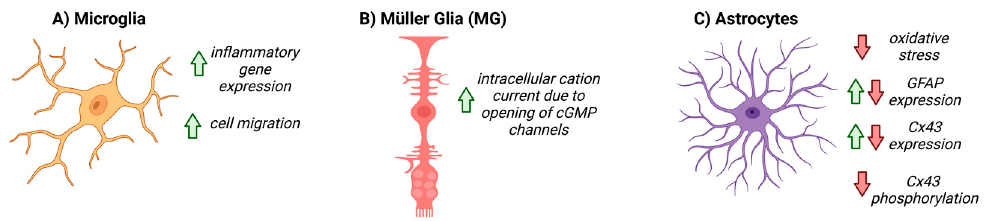
Figure 3. The known effects of cGMP on glial cells. Red arrows represent downregulation, or negative activity, green arrows represent increased expression, or positive activity. ( A ) cGMP upregulates inflammatory gene expression and cell migration in microglia, ( B ) increases cation current within Müller cells via opening of cGMP-gated channels, and ( C ) decreases oxidative stress, differentially affects GFAP and Cx43 expression, and decreases Cx43 phosphorylation in astrocytes. In cell types outside of the CNS, Cx43 expression and function is mediated by cGMP (SNAP) or 8-Br-cGMP increased expression of Cx43 [101]. Additionally, GC1 − / −